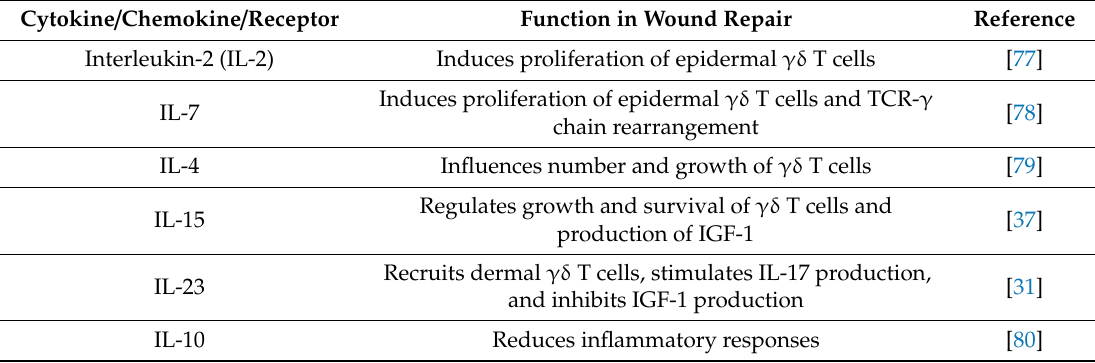
Table 2. Cytokines and chemokines that regulate and are regulated by γδ T cells in the skin. Cytokine / Chemokine /